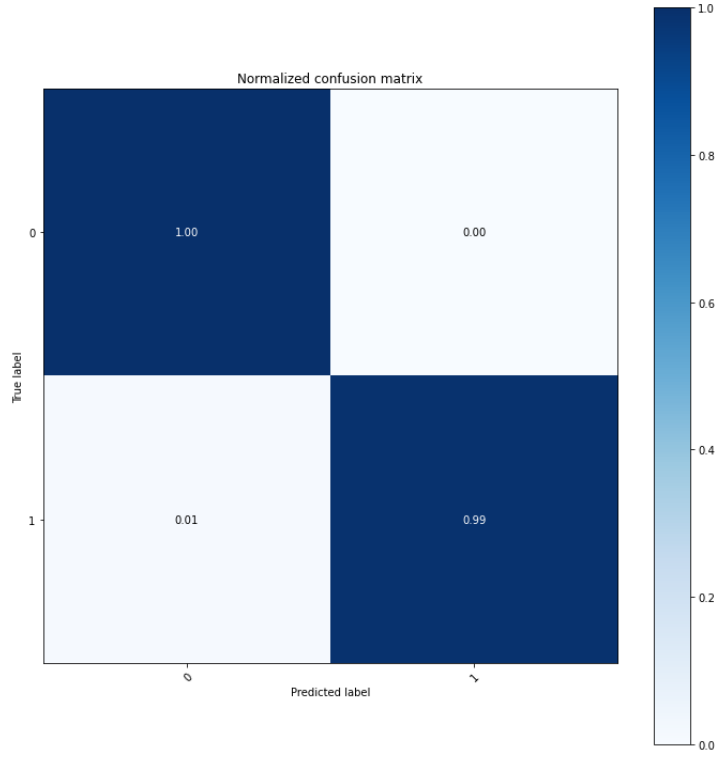
Figure 17. Confusion matrix for test